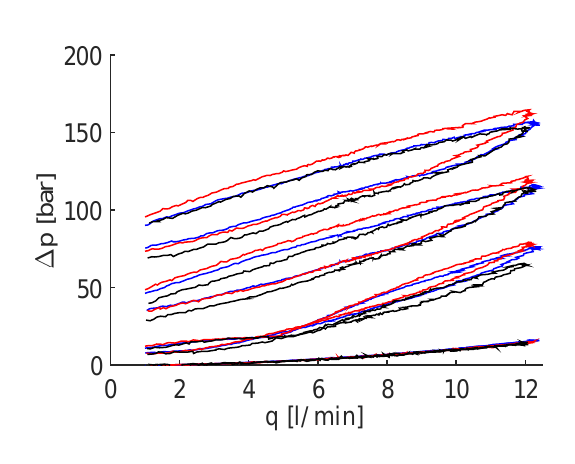
Figure 17: ∆ p (q) for HV(black) HEES(red) HEES+(blue) at 60 ◦